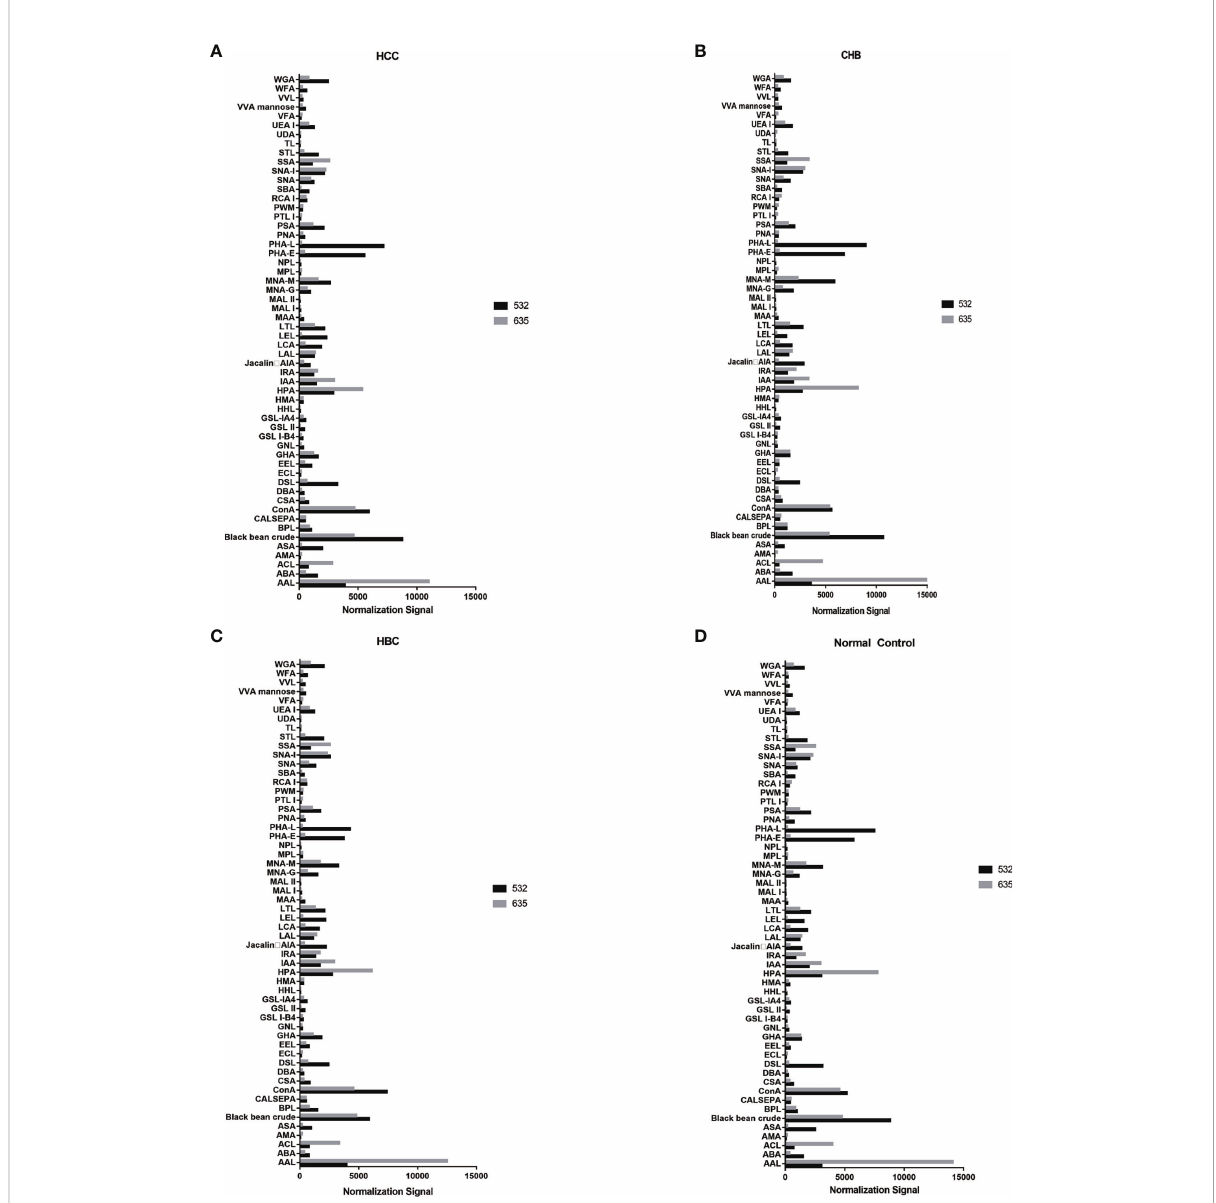
FIGURE 2 Distribution of normalized signal intensity values for 56 lectins. (A) Normalized values of 56 lectins in HCC. (B) Normalized values of 56 lectins in CHB. (C) Normalized values of 56 lectins in HBC. (D) Normalized values of 56 lectins of NC. 532 represents IgG, 635 represents